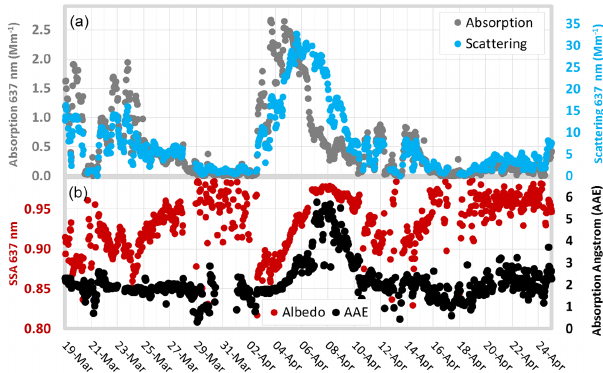
Figure 4. (a) Particle absorption and scattering coefficients at 637nm observed in situ at the ATTO site. (b) Particle single scat- tering albedo (SSA) at 637nm, and absorption Ångström exponent (AAE), retrieved from in situ observations of aerosol optical prop- erties at ATTO.